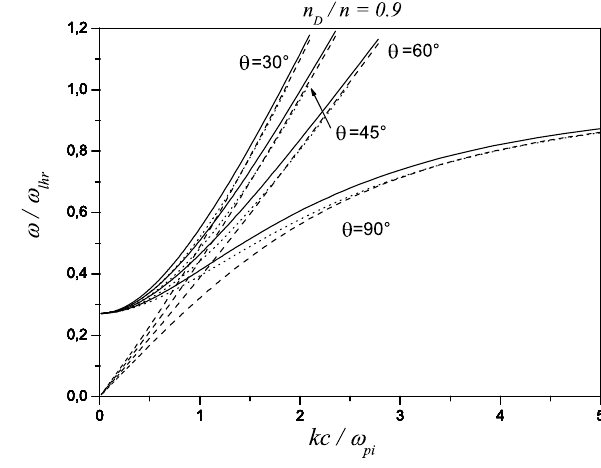
Fig. 2. Dispersion laws ( ω/ω lhr as a function of kc/ω pi ) for different wave vector orientations with respect to the magnetic field ( θ = 30, 45, 60, and 90 degrees) in a plasma with two pos- itive ions H + , O + , at an altitude h ’ 1900km, and with a neg- ative O − relative content of n D /n = 0 . 9. Main parameters are: ω cut ’ b ω cut1 ’ 6 . 26 ω H , b ω cut2 ’ 0 . 11 ω H , ω H / 2 π ’ 0 .